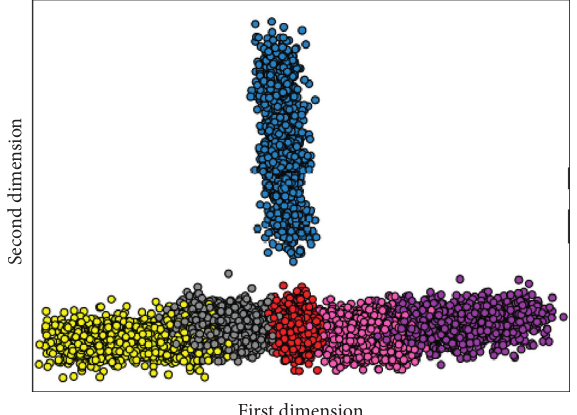
Figure 4: Two-dimensional scatter plot of PCA processed data.